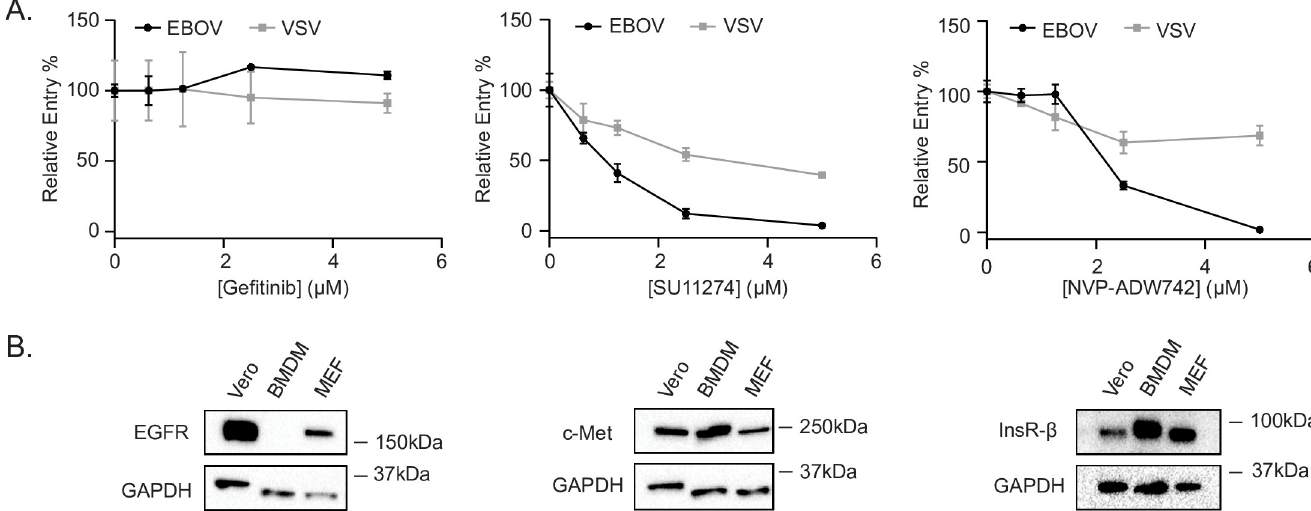
Fig 4. Effect of RTK inhibitor treatment on EBOV GP-mediated entry in BMDMs. (A) Entry of β lam VLPs harboring EBOV GP or VSV G in BMDMs treated with vehicle (DMSO, 0.1%) or increasing concentrations of Gefitinib, SU11274, or NVP-ADW742. (B) Vero cells, BMDMs, and MEFs were serum-starved, lysed, and expression of EGFR, Met, InsR- β , and GAPDH was detected by immunoblotting. Results in (A) are expressed as mean ± s.d. of triplicates and are representative of 3 experiments. Results in (B) are representative blots of 3 independent experiments.